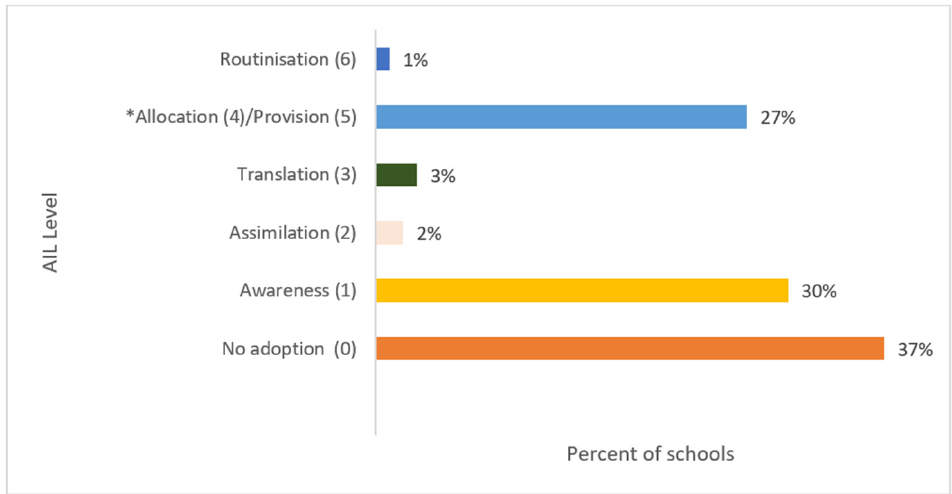
Figure 2. Overall adoption of the Ed-LinQ initiative in Queensland schools ( n = 186) according to the Adoption Impact Ladder (AIL). The Allocation and Provision levels of the AIL were merged for the analysis of this initiative into a single level (Level 5). * Level 4 and 5 merged for this study.